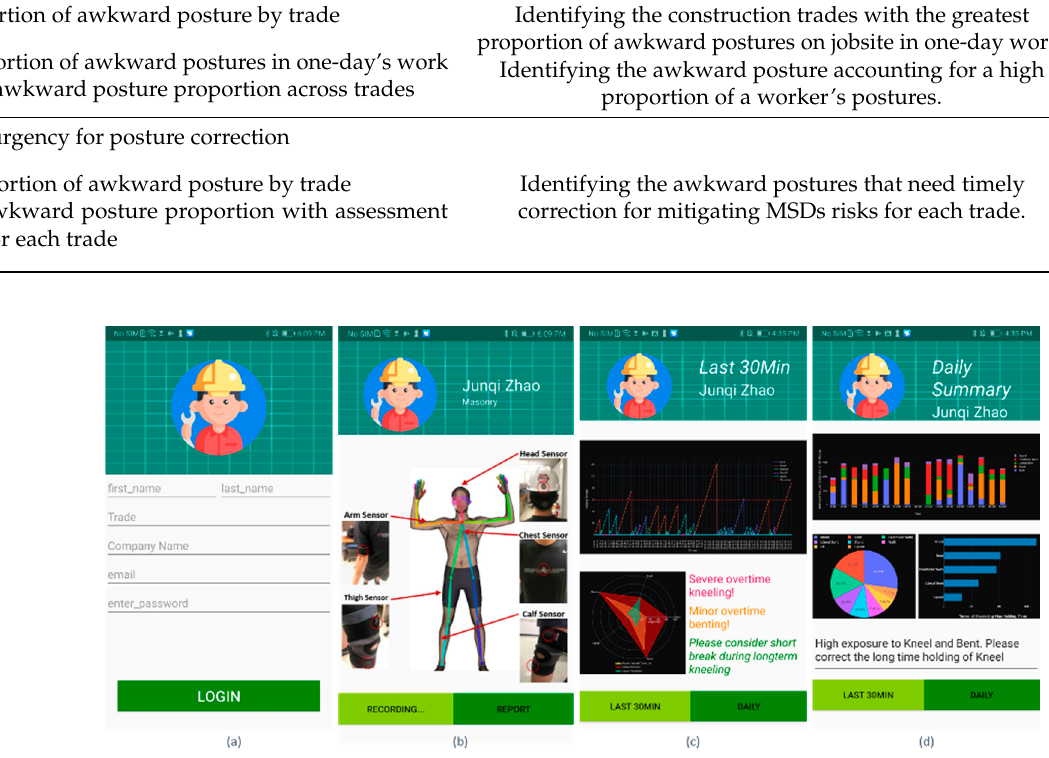
Figure 6. Mobile application UI, which includes: ( a ) login interface, ( b ) sensor placement instructions, ( c ) 30-min assessment feedback, and ( d ) daily assessment